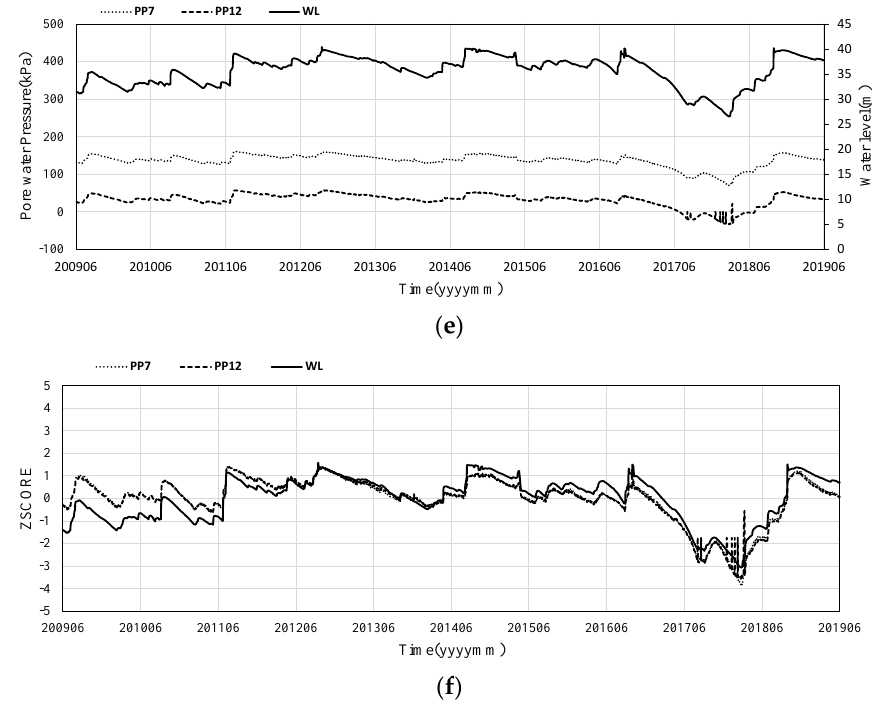
Figure 8. Relationships between water level and porewater pressure for group A: ( a ) comparisons with water level and Group A-a; ( b ) z-score for group A-a with water level; ( c ) comparisons with water level and Group A-b; ( d ) z-score for group A-b with water level; ( e ) comparisons with water level and Group A-c; ( f ) z-score for group A-c with water level.